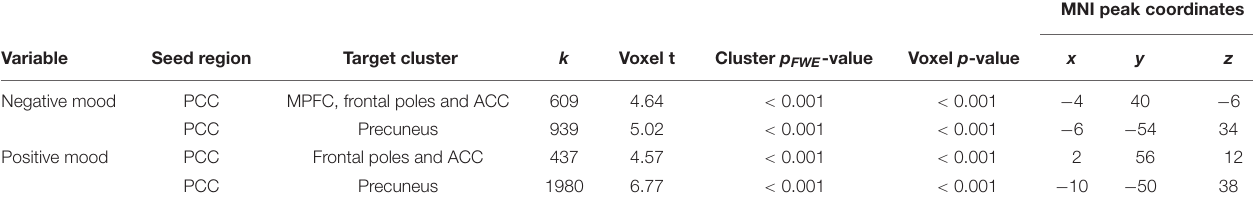
TABLE 3 | Results of whole-brain seed-to- − voxel resting-state functional connectivity analyses and their associations with daily mood